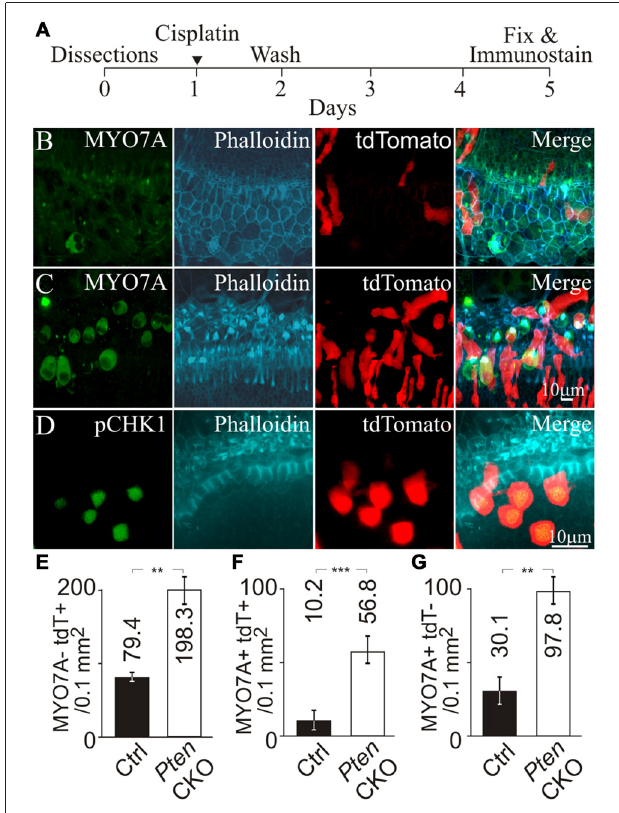
FIGURE 5 | Hair cell survival after genetic activation of PI3K signaling and cisplatin damage. (A) Timeline of cochlear explant cultures describing the addition of 10 µ M cisplatin treatment for cochlear explants. MYO7A, phalloidin, tdTomato and merged fluorescent images from (B) NS Cre tdTomato (control) after cisplatin treatment ( n = 4) and (C) NS Cre Pten cKO tdTomato ( Pten cKO) cochleae after cisplatin treatment ( n = 4). (D) pCHK1, phalloidin, tdTomato and merged fluorescent images from Pten cKO mouse after cisplatin damage. (E) Density (cells/0.1 mm 2 ) of MYO7A- tdTomato+ supporting cells in control ( n = 4) and Pten cKO cochleae ( n = 4). (F) Density of MYO7A+ tdTomato+ hair cells in control ( n = 4) and Pten cKO cochleae ( n = 4). (G) Density of MYO7A+ tdTomato- hair cells in control ( n = 4) and Pten cKO cochleae ( n = 4). Statistical significance was determined using the Student’s t -test and error bars are in SD.